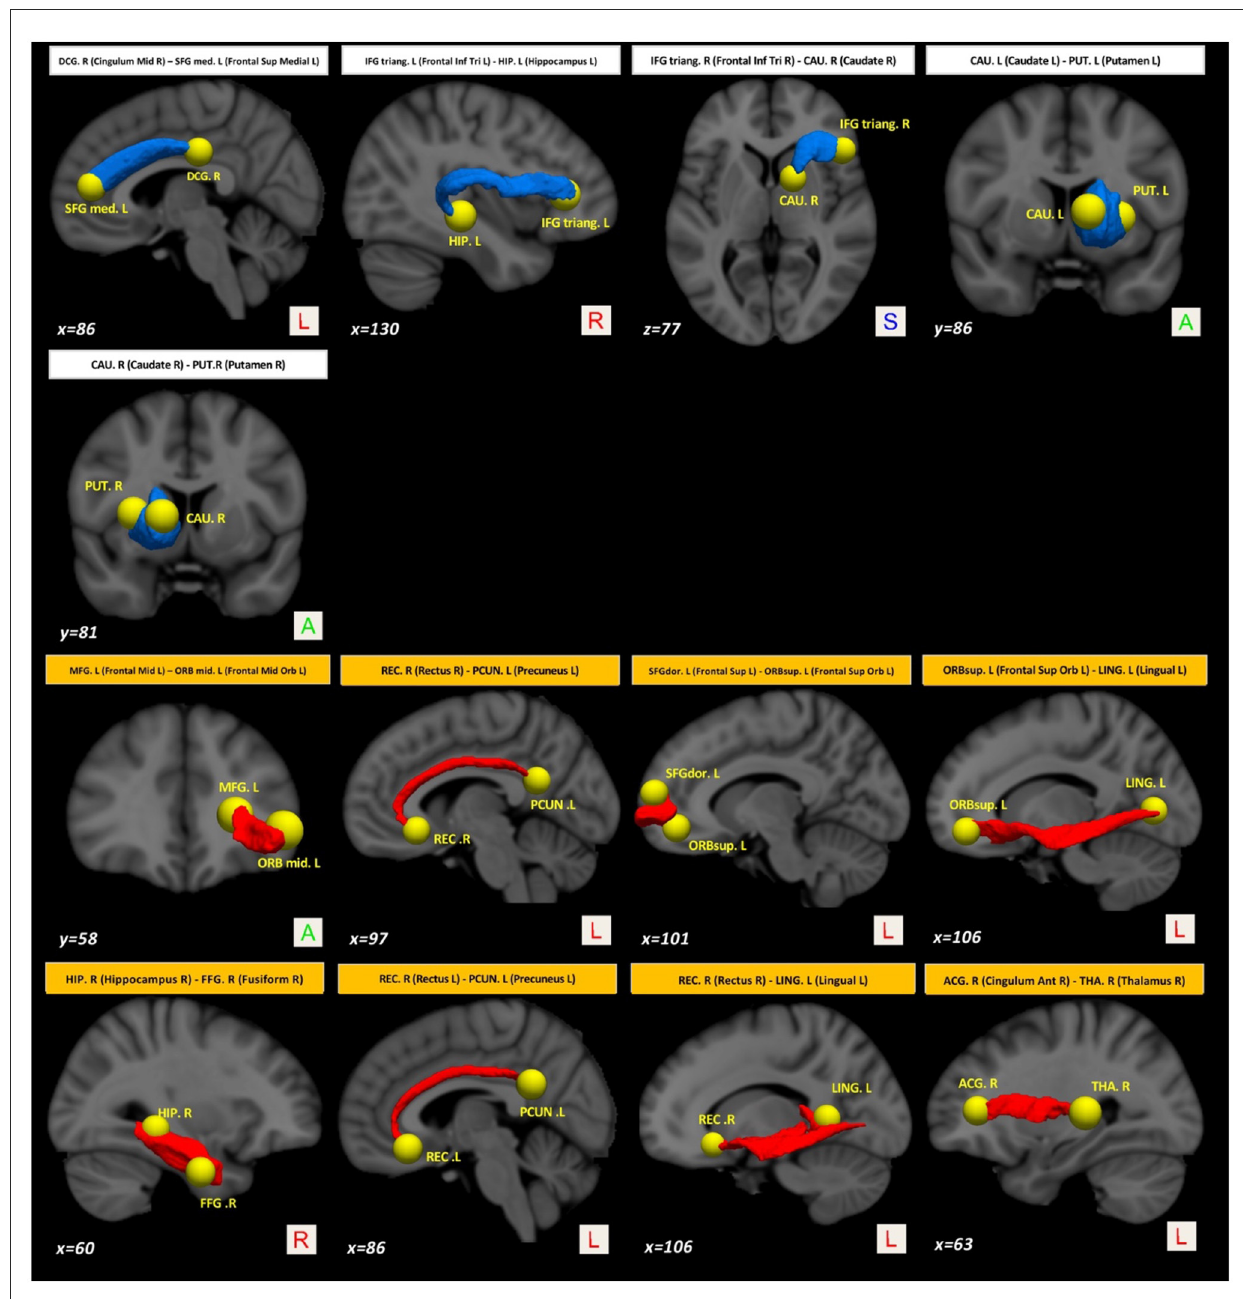
FIGURE5 Tract reconstructions corresponding to structural connectivity differences in PD between baseline and after 36 months. The tracts were reconstructed by connectome2tck (MRtrix3) in the native space for all HC subjects, converted to track-weighted image by tckmap (MRtrix3), and normalized and averaged in the MNI 1mm standard space. For the visualization, Trackvis software (https://www.trackvis.org) was used. The blue tracts show higher connectivity in PD at the baseline. The red tracts show higher connectivity in PD after 36